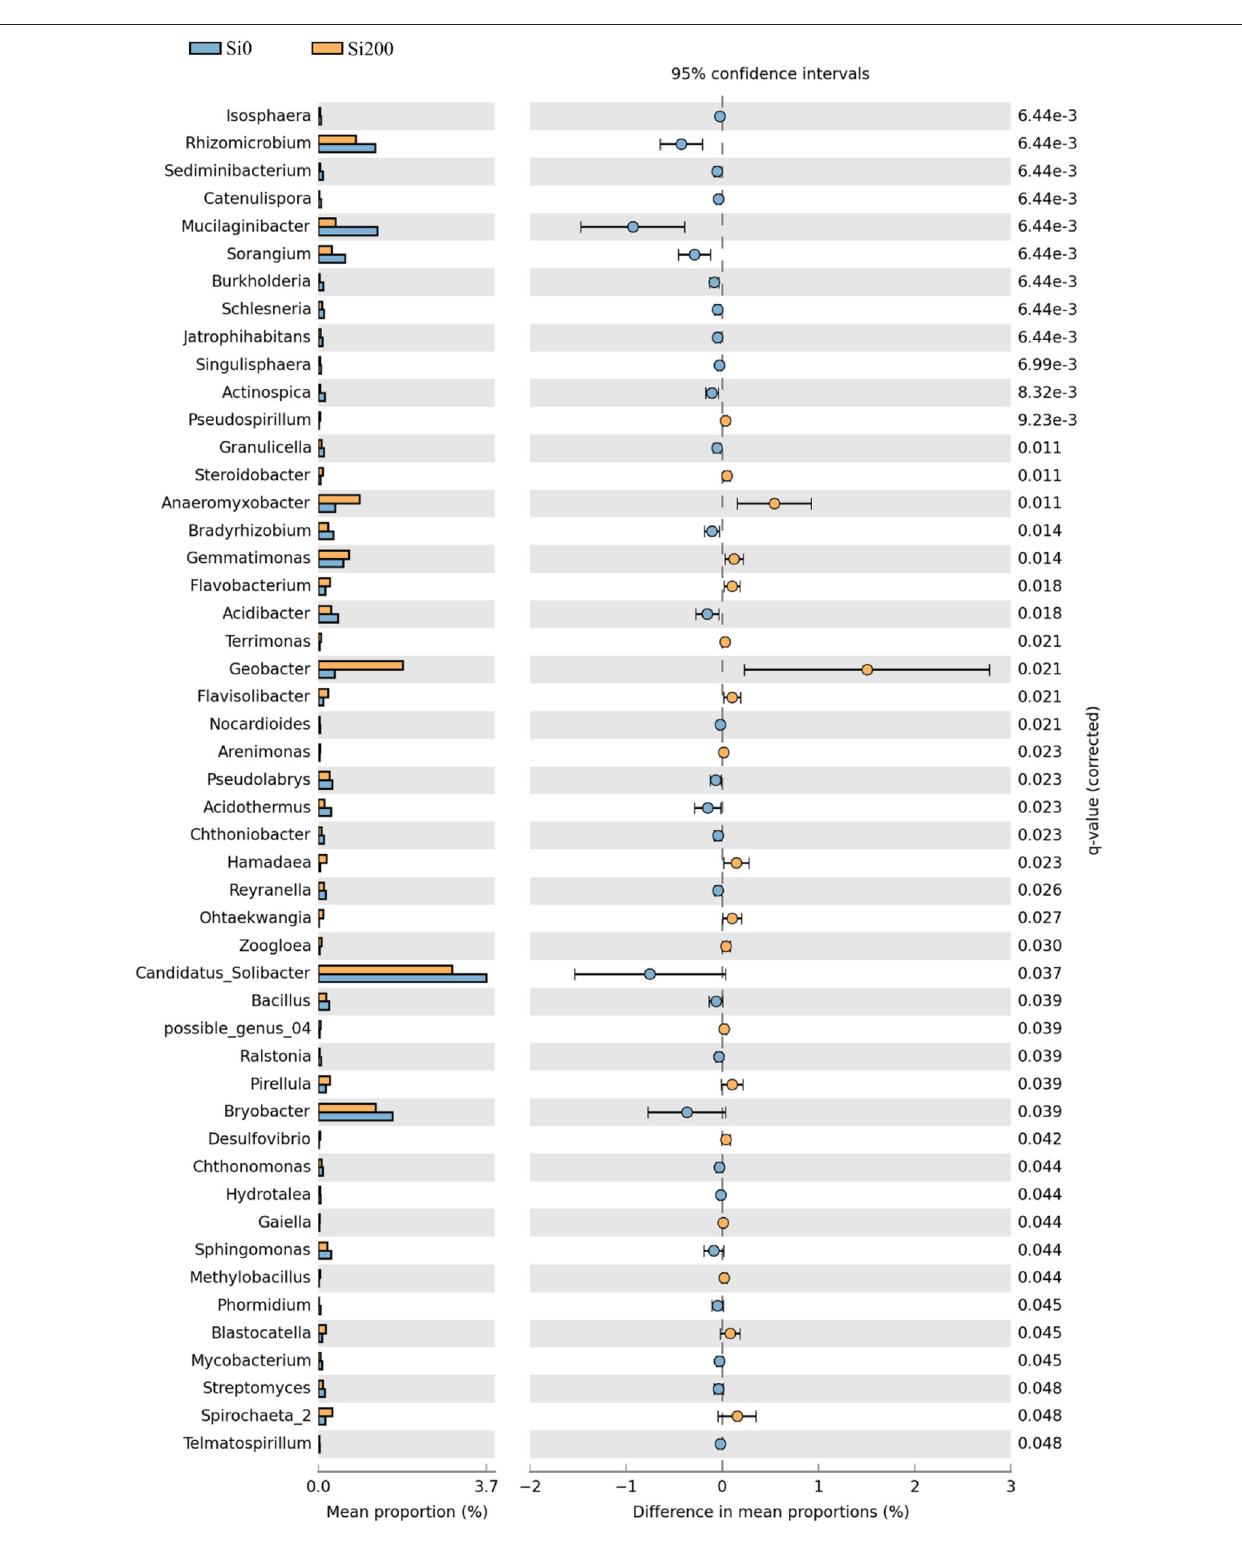
Frontiers in Plant Science |